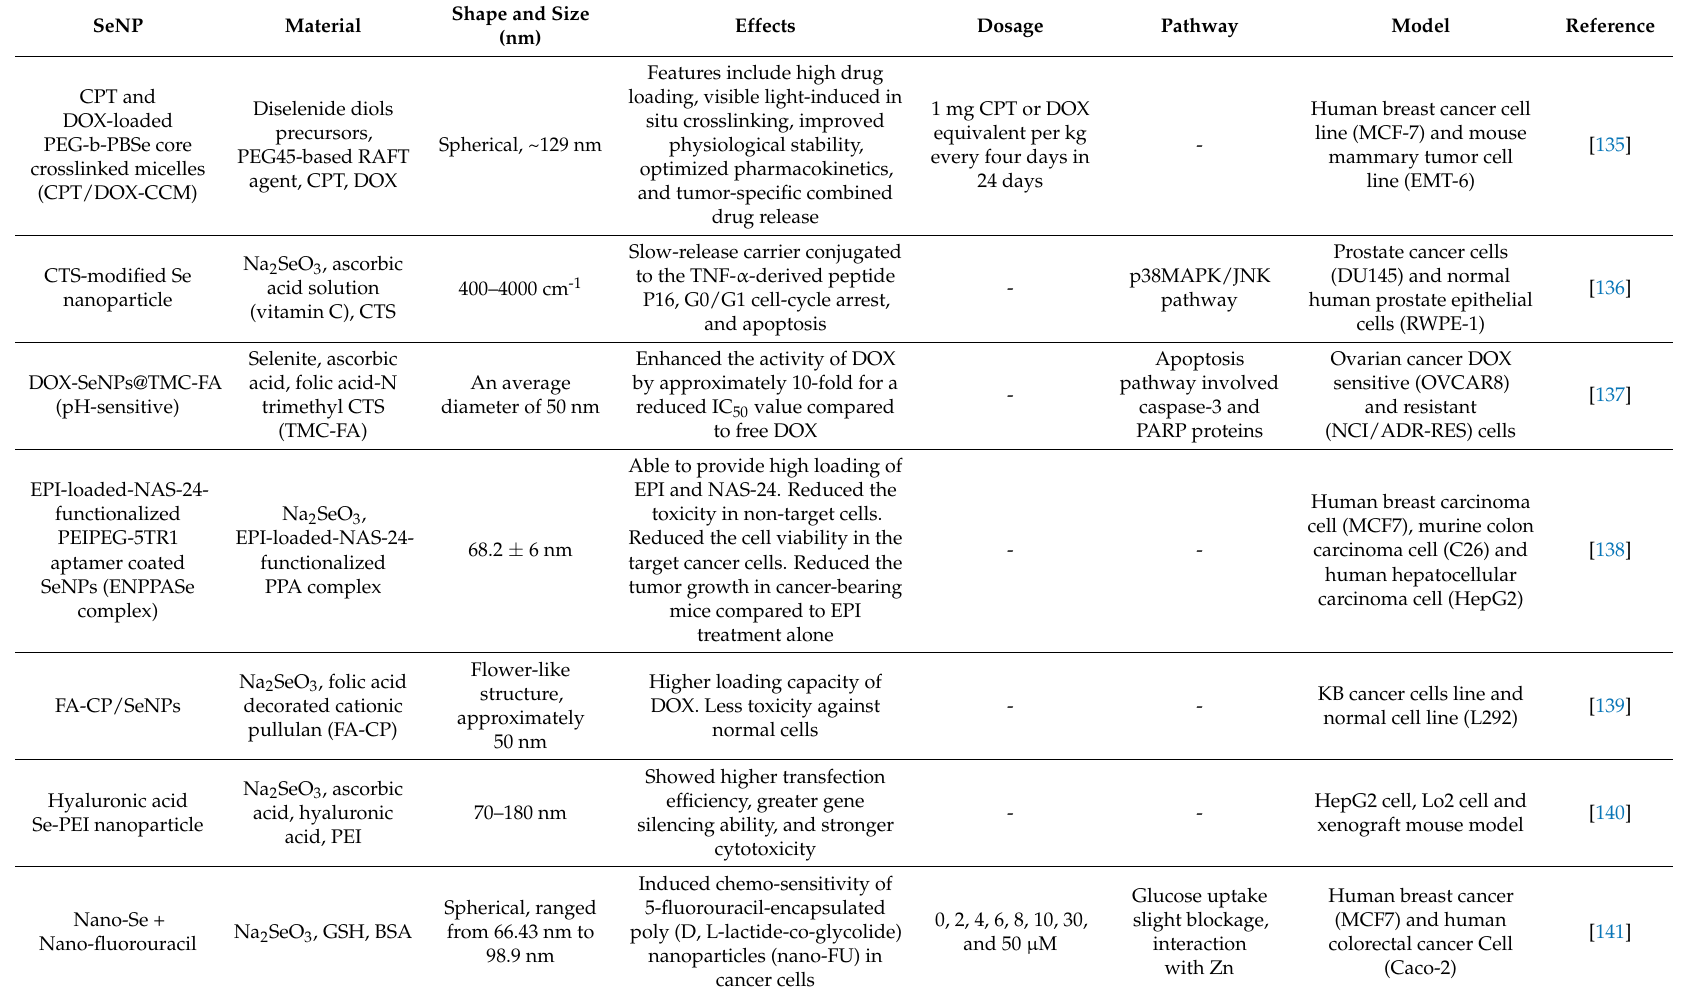
Table 2. Summary of recent work on SeNPs with potential for anti-cancer drug